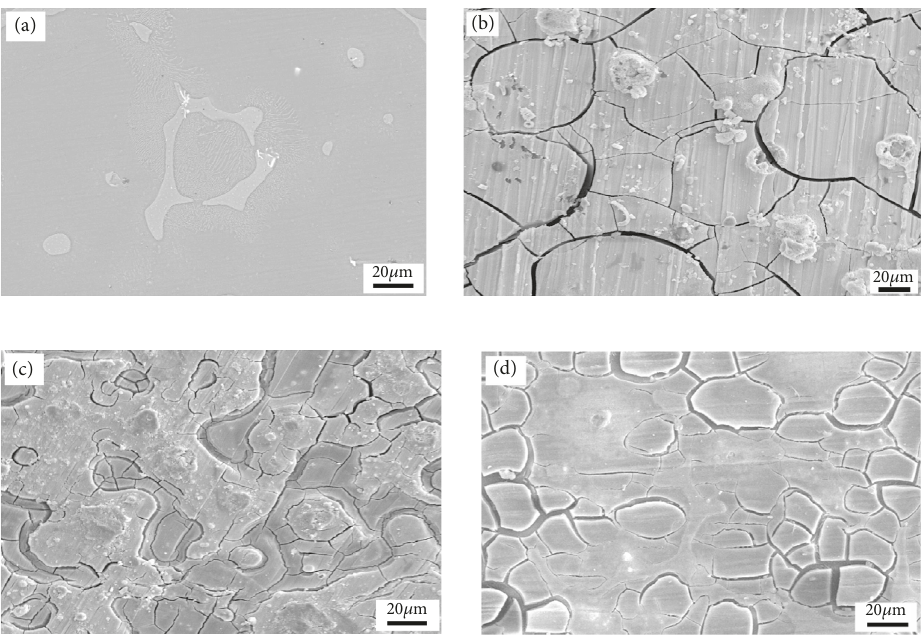
Figure 4: Morphologies of conversion coatings with various processes on AZ91D alloys: (a) unhandled-AZ91D, (b) CO 2 24h, (c) CO 2 2h/pH11.5 2h, and (d) CO 2 3MPa